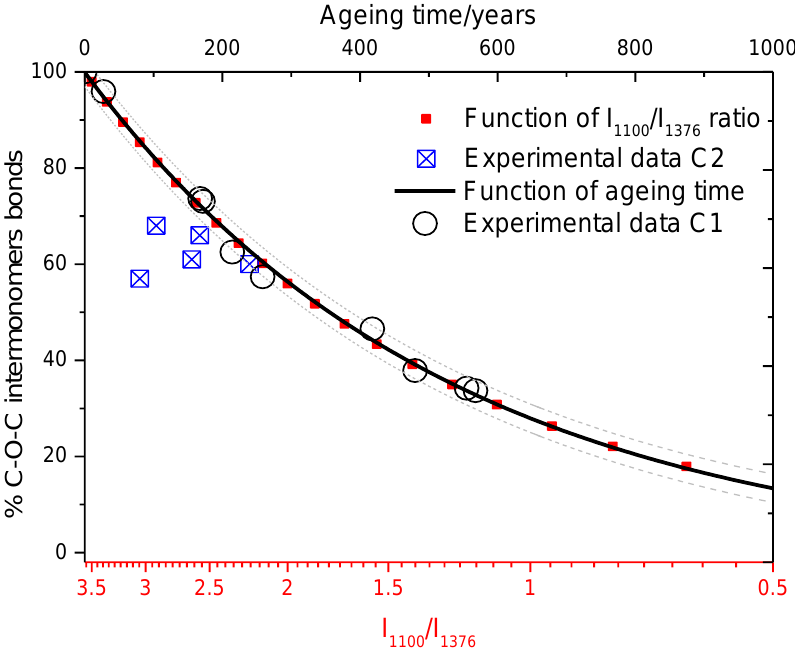
Figure 5. Aging and degradation model with experimental data: COC residual percentage of inter-monomer bonds as a function of aging time and I 1100 / I 1376 intensities ratio. (Reproduced from work in [11] with the permission of Wiley, copyright 2018.)